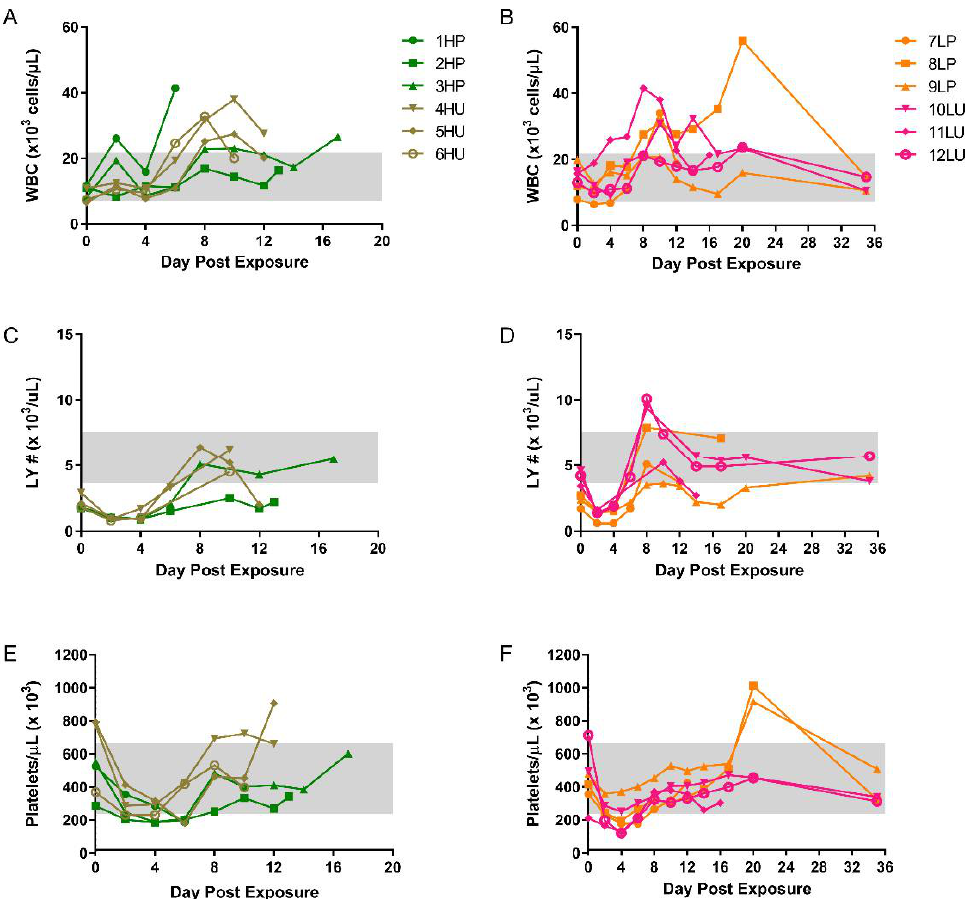
Figure 5. Temporal hematological changes in cynomolgus macaques intravenously exposed to either purified or unpurified monkeypox virus at two different doses. Whole EDTA blood was run on the Beckman Coulter AcT 10. Absolute white blood cell counts (WBC) ( A , B ), lymphocyte number (LY#) ( C , D ), and platelets ( E , F ) are shown. HP, high dose purified; low dose purified, LP; high dose crude, HU; low dose crude, LU. Normal ranges (grey boxes) were previously reported [21], except figures ( C , D ).